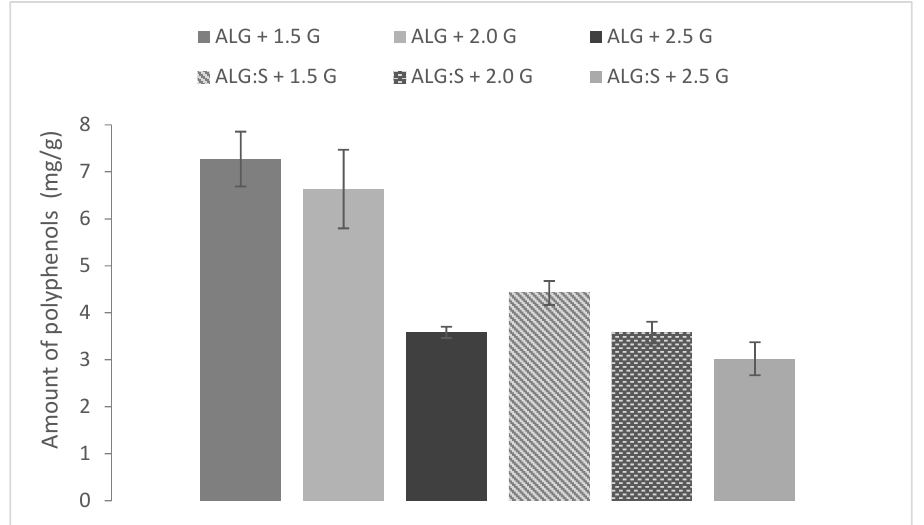
Figure 3. Loading capacity of sodium alginate-based films with loaded gelatin microspheres: ALG + 1.5 G, ALG + 2.0 G, ALG + 2.5 G—samples based on sodium alginate containing 1.5%, 2%, and 2.5% of glycerin, respectively. ALG: S + 1.5 G, ALG: S + 2.0 G, ALG: S + 2.5 G samples based on sodium alginate and starch containing 1.5%, 2%, and 2.5% of glycerin,